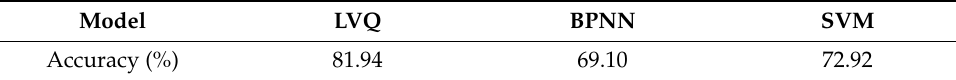
Figure 16. Confusion matrix of the three classification models. ( a ) Confusion matrix of LVQ model . ( b ) Confusion matrix of BPNN model . ( c ) Confusion matrix of SVM model . Table 12. Model identification accuracy.